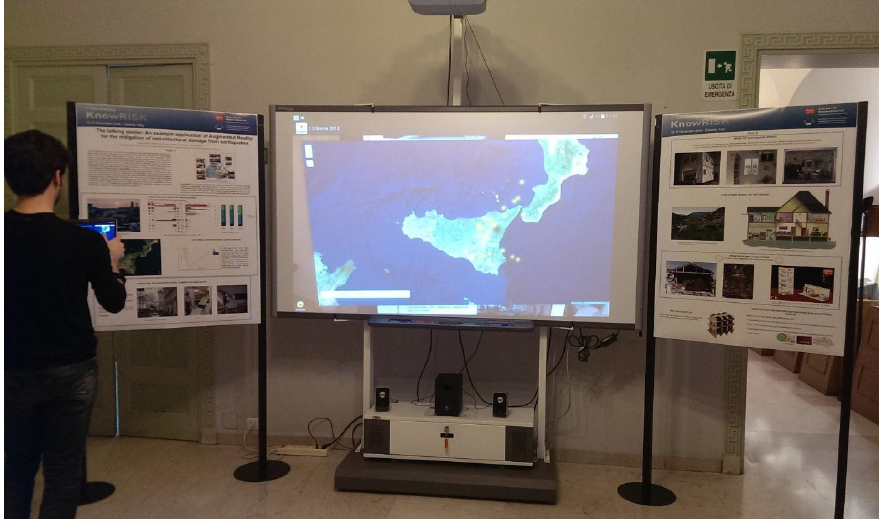
Figure 4. The talking poster on 15 December 2016 in Catania (Italy). The digital interactive whiteboard (in the central part of the image) dynamically depicted the epicenter location of earthquakes in Sicily (yellow circles on the map; photo credits: Susanna Falsaperla).